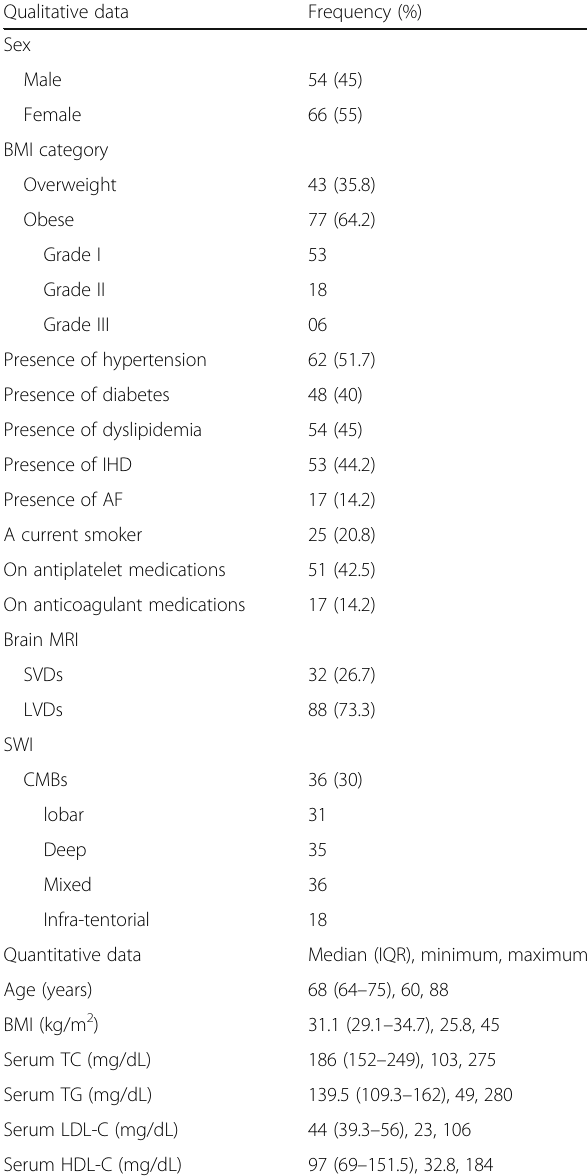
Table 1 Characteristics of the study cohort ( n = 120) Qualitative